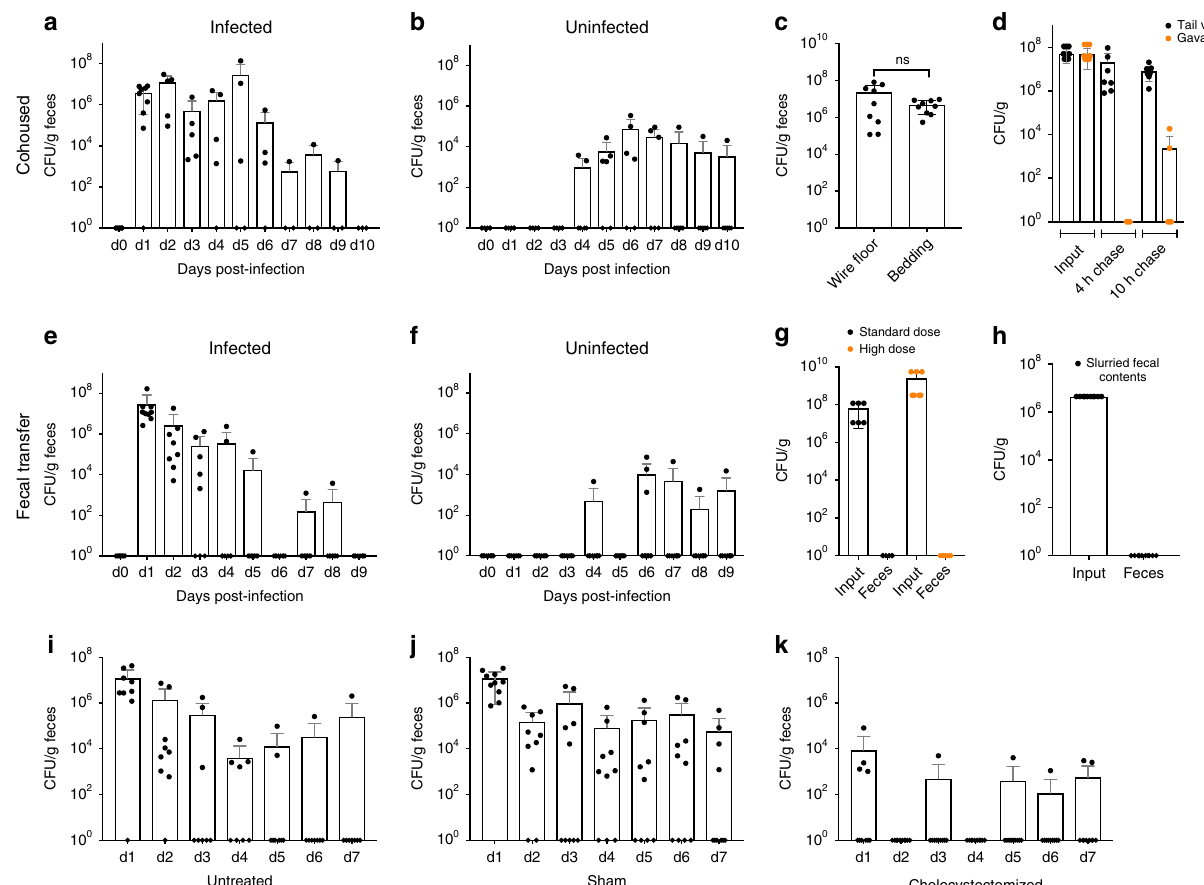
Fig. 3 The gallbladder promotes prolonged intestinal shedding of P. aeruginosa following bacteremia. BALB/c mice were injected with ~8 × 10 5 CFU of PABL012 lux ( a ) and co-housed with 2 uninfected cage-mates ( b ) for 10 days ( n = 3 x 3 replicates infected, n = 2 x 3 replicates uninfected). Fecal pellets were collected from individual mice daily. c Mice intravenously infected with ~2 × 10 6 CFU of PABL012 lux were housed on normal bedding or raised wire racks ( n = 3 × 3 replicates), and PA was measured in the feces at 24 hpi. (ns) not signi fi cant by Mann – Whitney test. d Mice were infected intravenously with ~2 × 10 6 CFU of PABL012 lux (black circles), followed 4 h ( n = 7 total, 2 replicates) or 10 h ( n = 9 total, 2 replicates) later with oral gavage of ~2 × 10 6 CFU of PABL012 GM (orange circles) and PA was measured in the feces at 24 hpi. BALB/c mice ( n = 4 x 2 replicates) were injected with ~8 x 10 5 CFU of PABL012 lux and all excreted fecal pellets from infected mice ( e , n = 8) were transferred daily to the cages of uninfected mice ( f , n = 9). Fecal pellets were collected from individual mice daily. g Mice were orally administered standard (~2 × 10 6 CFU, n = 3 × 2 replicates, black circles) or high (~3 × 10 8 CFU, n = 4 × 2 replicates, orange circles) doses of PABL012 lux by gavage, and PA was measured in the feces at 24 hpi. h Fecal pellets from previously infected mice ( n = 25) were slurried and orally administered (~2 × 10 5 CFU) to uninfected mice by gavage. PA was measured in the feces at 24 hpi. For input 1 g equals 1 mL of wet weight. i – k Mice ( n = 5 x 2 replicates) following sham surgery ( j ) and mice following cholecystectomy ( k ) and mice that had not undergone surgery ( i ), were challenged intravenously with ~2 × 10 6 CFU of PABL012 lux and fecal pellets collected daily. On day 1, p values were determined for wild type vs. sham ( p = 0.9, ns), wild type vs. cholecystectomized (** p = 0.004), and sham vs. cholecystectomized (*** p = 0.0005) mice via a Kruskal – Wallis analysis to correct for multiple comparisons. For scatter plots, each circle (or diamond) represents data from one mouse, and data are presented as PA shed in CFU per gram feces [CFU/g]. When no bacterial CFU were recovered, data are represented as diamonds on the x -axis. Geometric means (boxes), and SD (whiskers) are